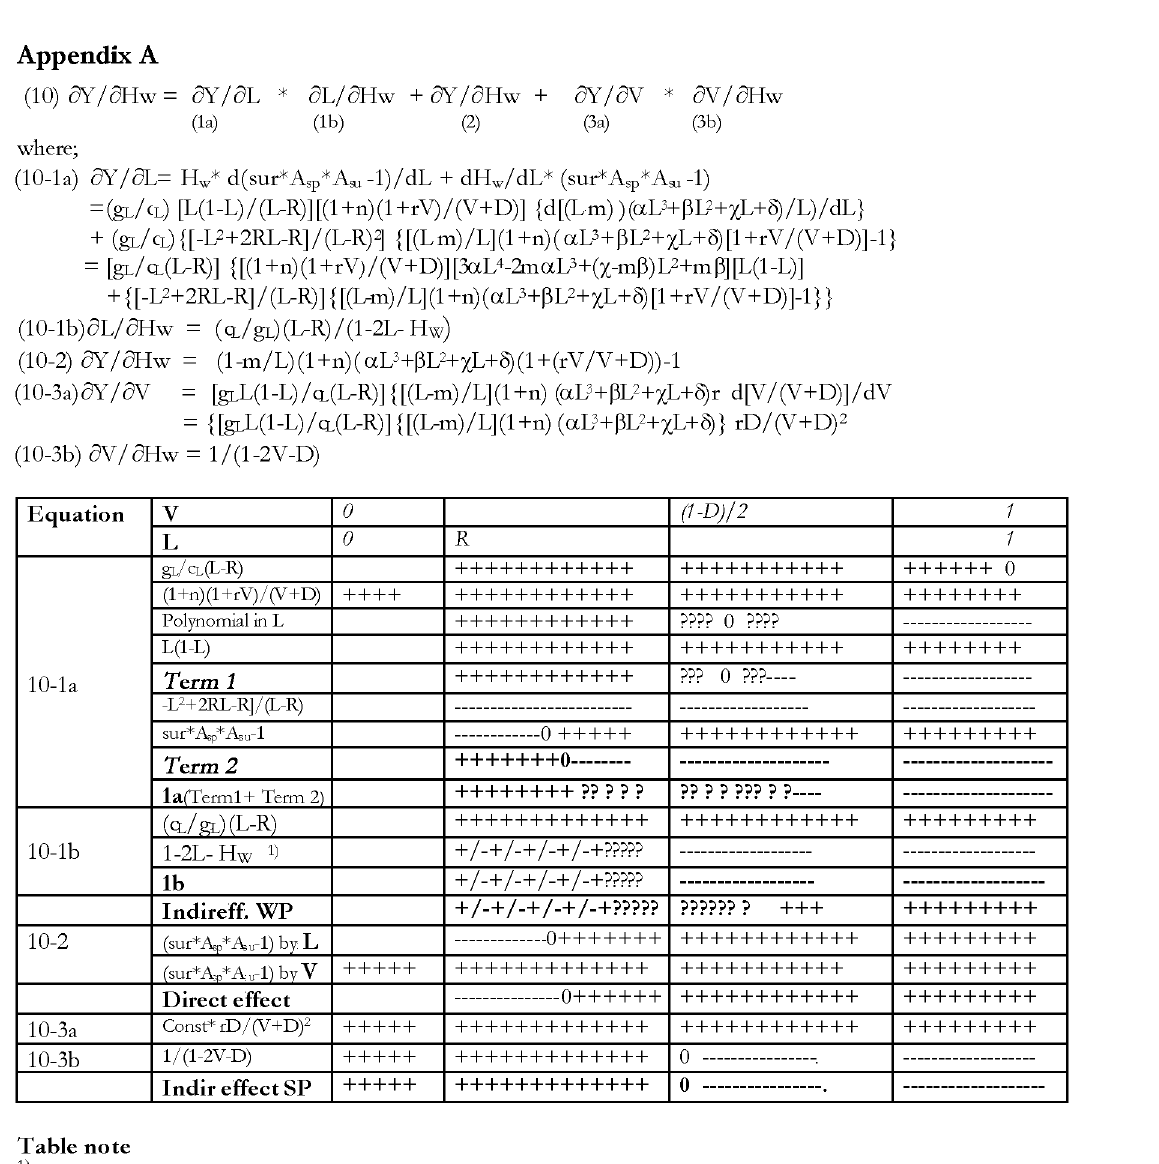
Table note 1) Sign for low values of L will depend on the relative size between L and H. Positive for combinations of low L and